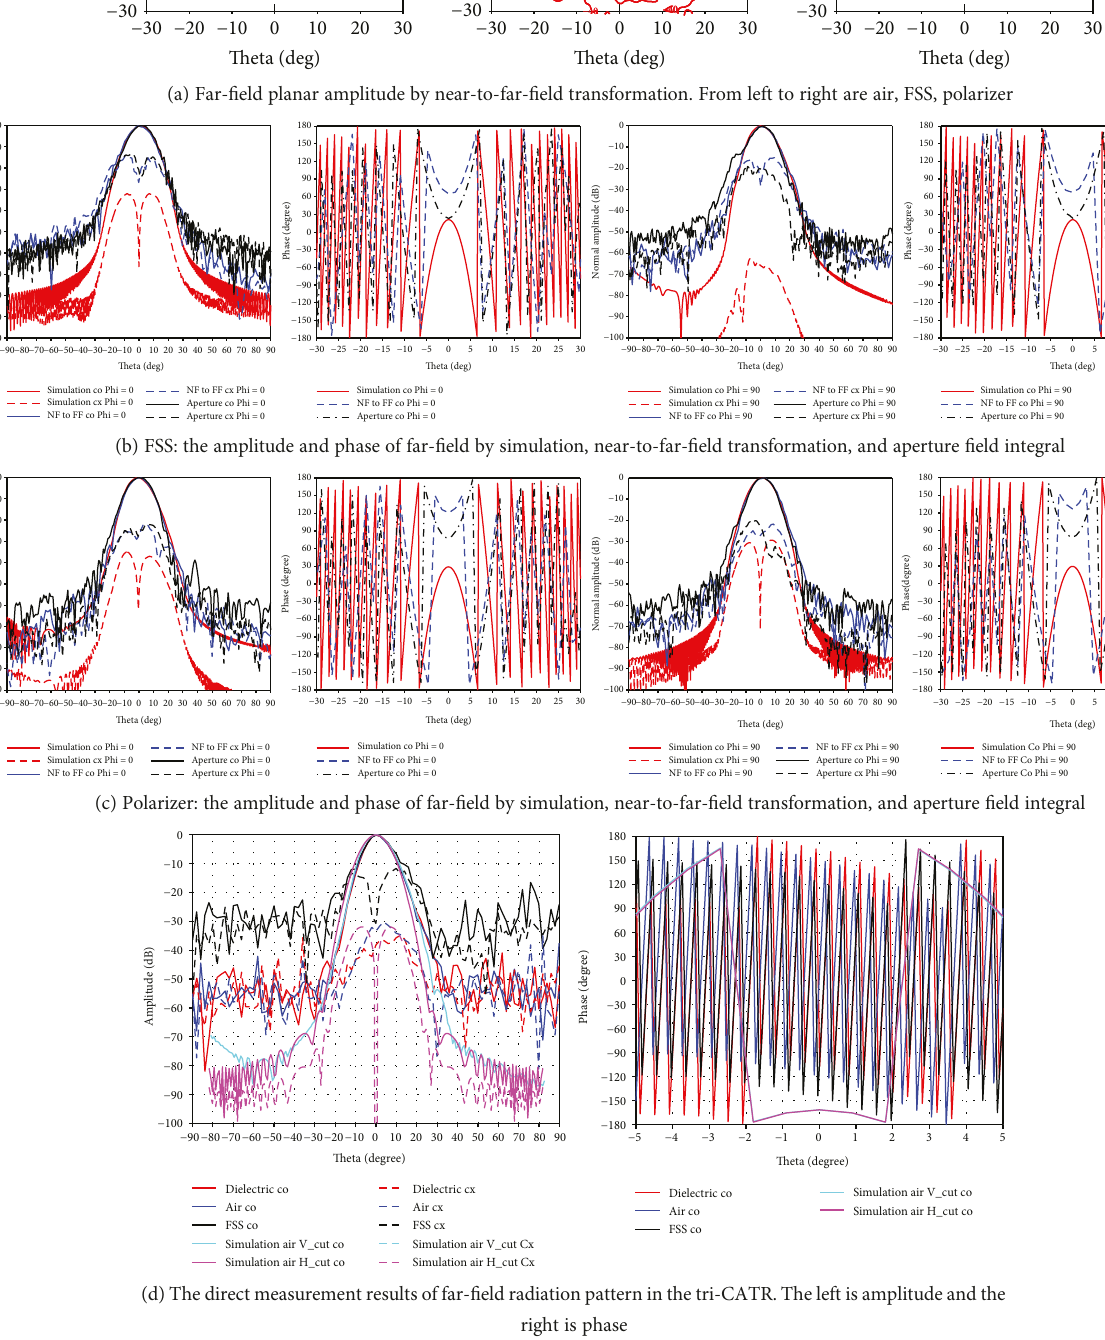
Figure 13: The far- fi eld radiation pattern results of 324GHz